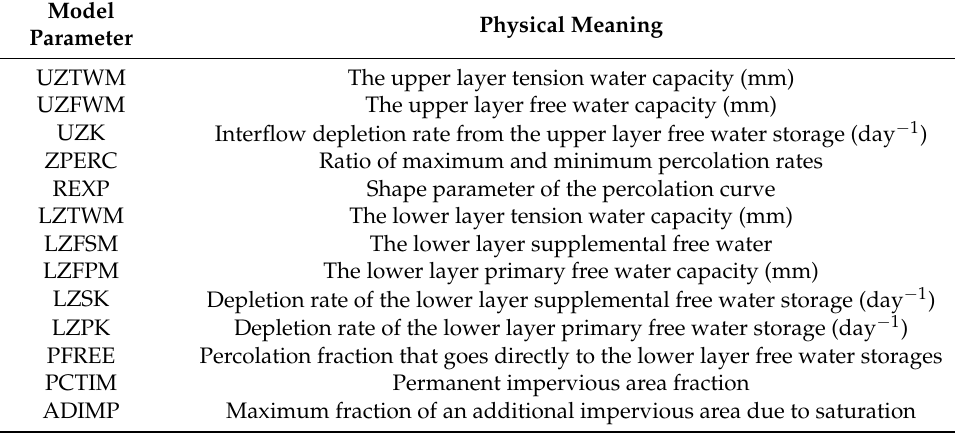
Table 2. SAC-SMA model parameter